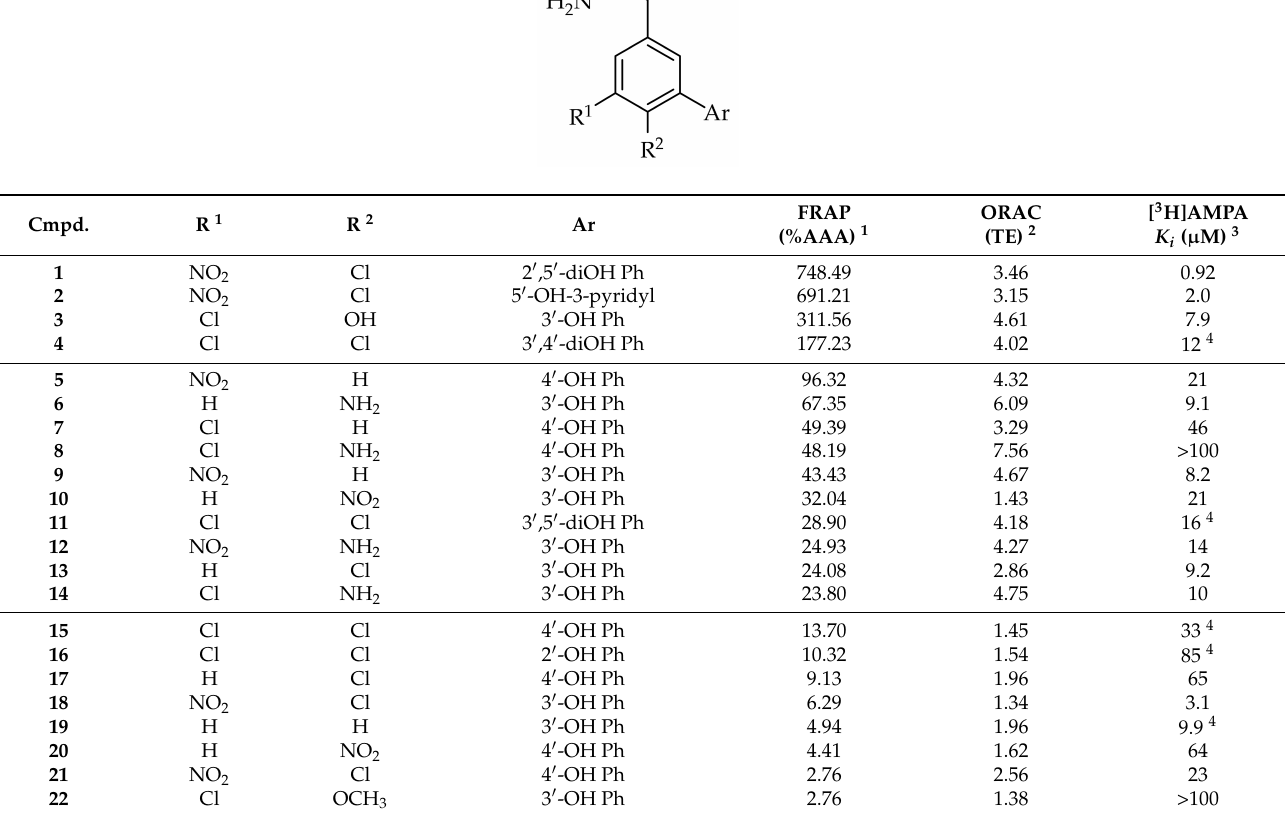
Table 1. The structures of racemic phenylalanine derivatives 1 – 22 and their antioxidant properties compared to α -amino-3-hydroxy-5-methyl-4-isoxazolepropionic acid (AMPA) receptor affinity.